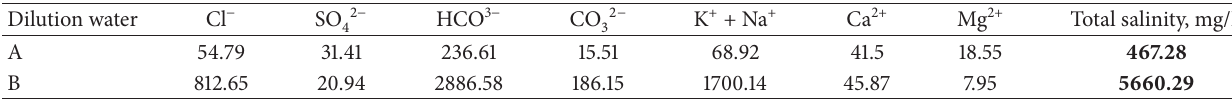
Table 1: Dilution water